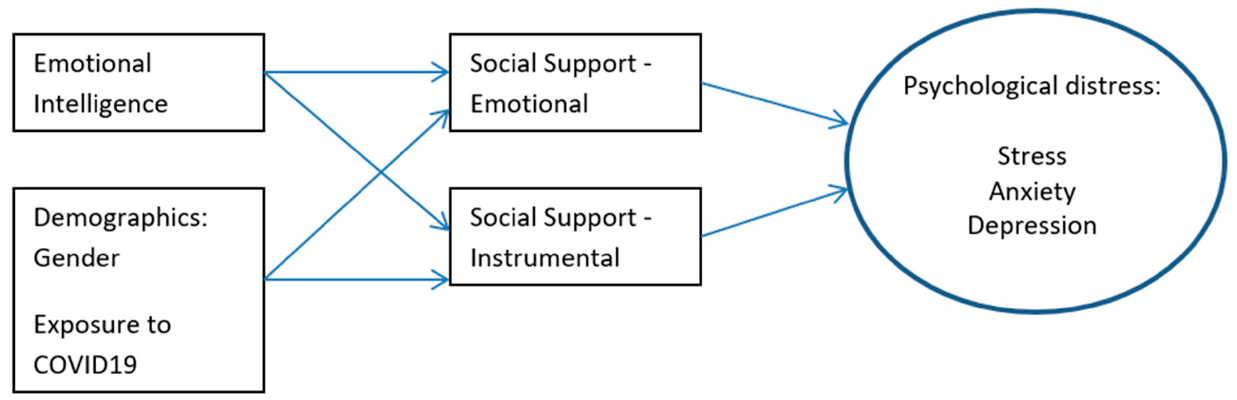
Figure 1. The Study Model.